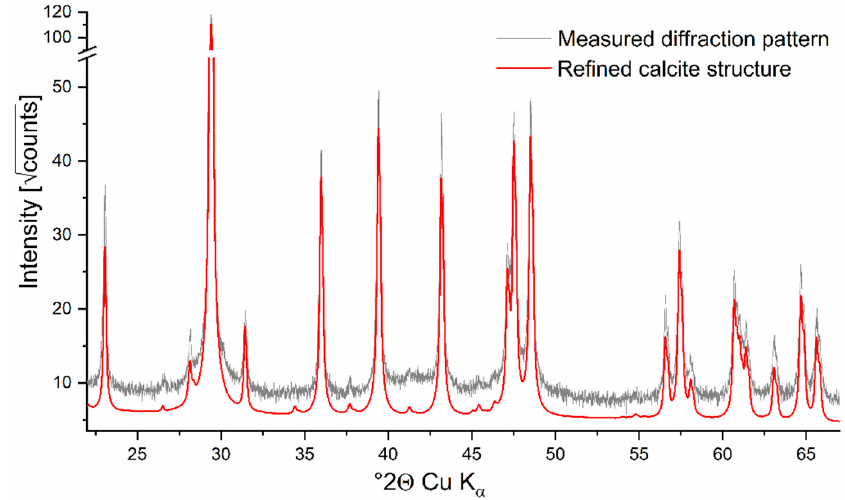
Figure 1. XRD spectra of Pneophyllum cetinaensis showing calcite as the only crystallite phase ( n = 1).